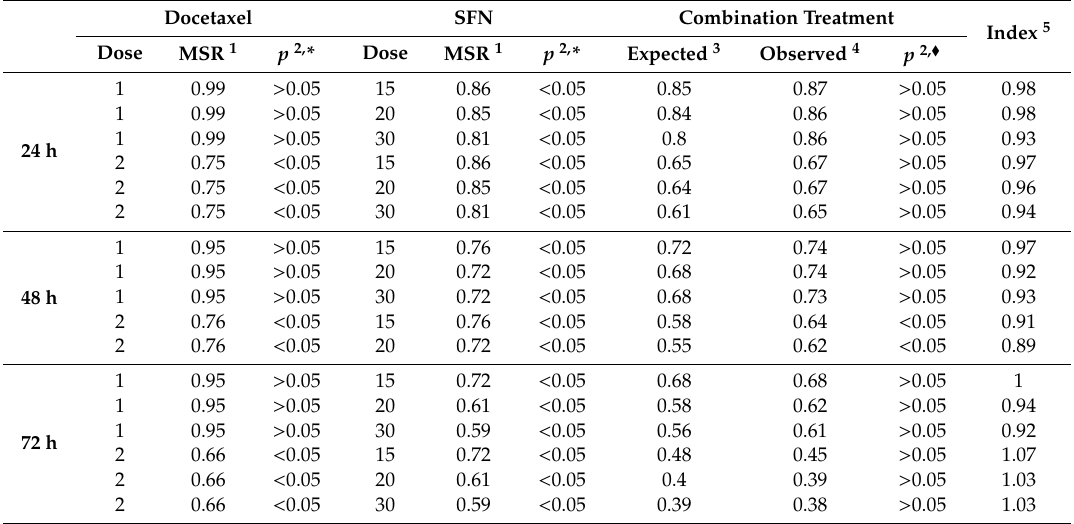
Table A3. Analysis of synergy between SFN and DOCE calculated by survival rate for PC-3 cells.